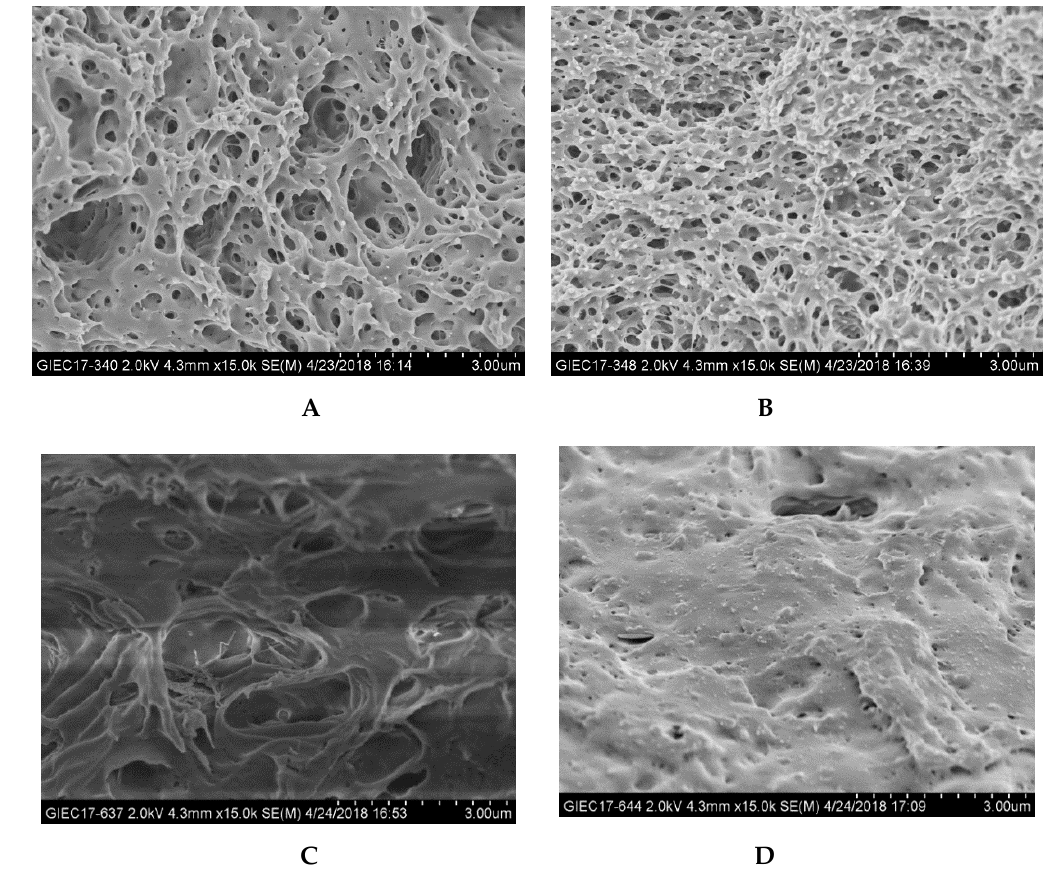
Figure 2. SEM images of the p(OPal-MMA) membranes prepared by different mixed solvents. ( A ), S1-3; ( B ), S2-4; ( C ), S3-2; ( D ), S4-2.